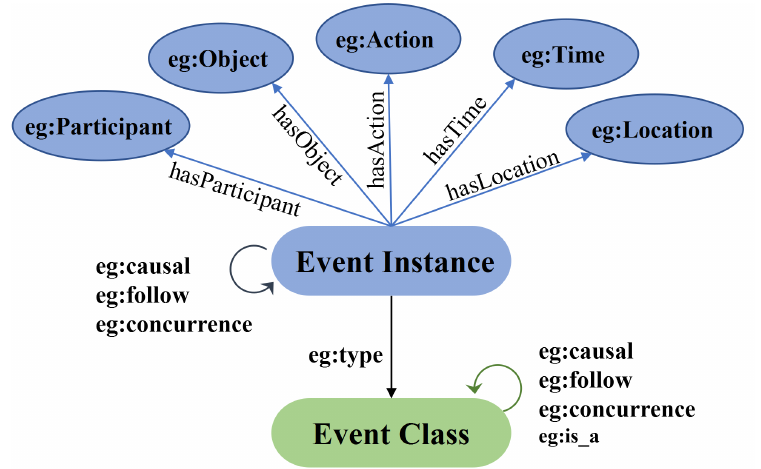
Figure 1. Event knowledge graph model